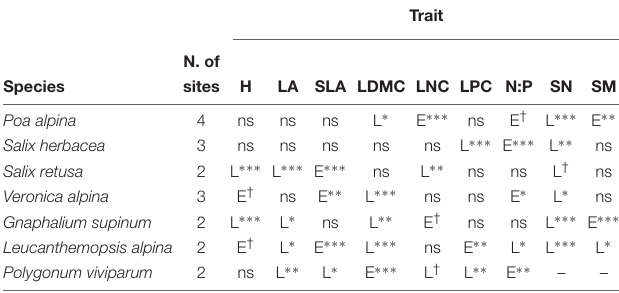
TABLE 1 | Results of linear mixed effect models for differences between early and late snowmelt areas of single plant traits for each study species across the four study